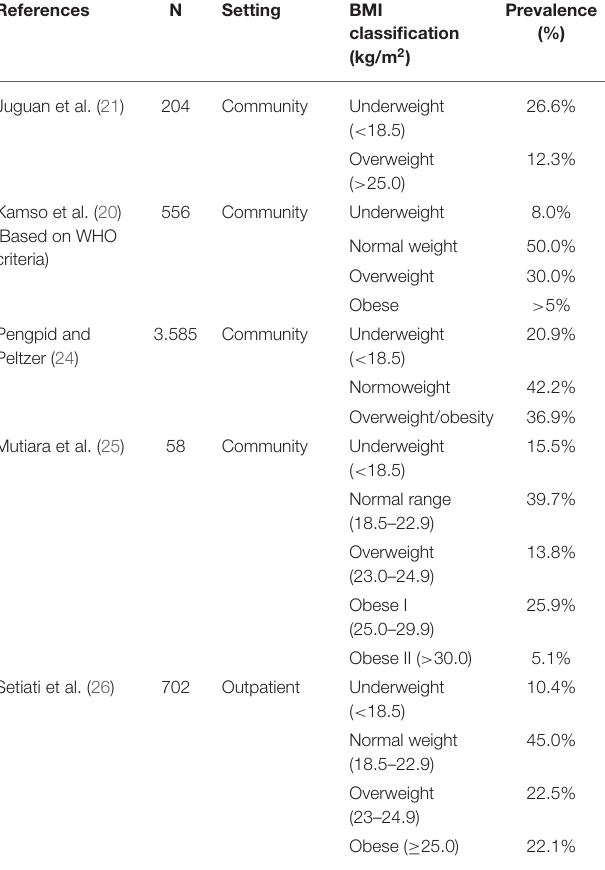
TABLE 3 | Prevalence of malnutrition based on BMI categories in older adults. TABLE 4 | Prevalence (percentage of total population) of malnutrition in older adults based on MNA (Mini Nutritional Assessment)